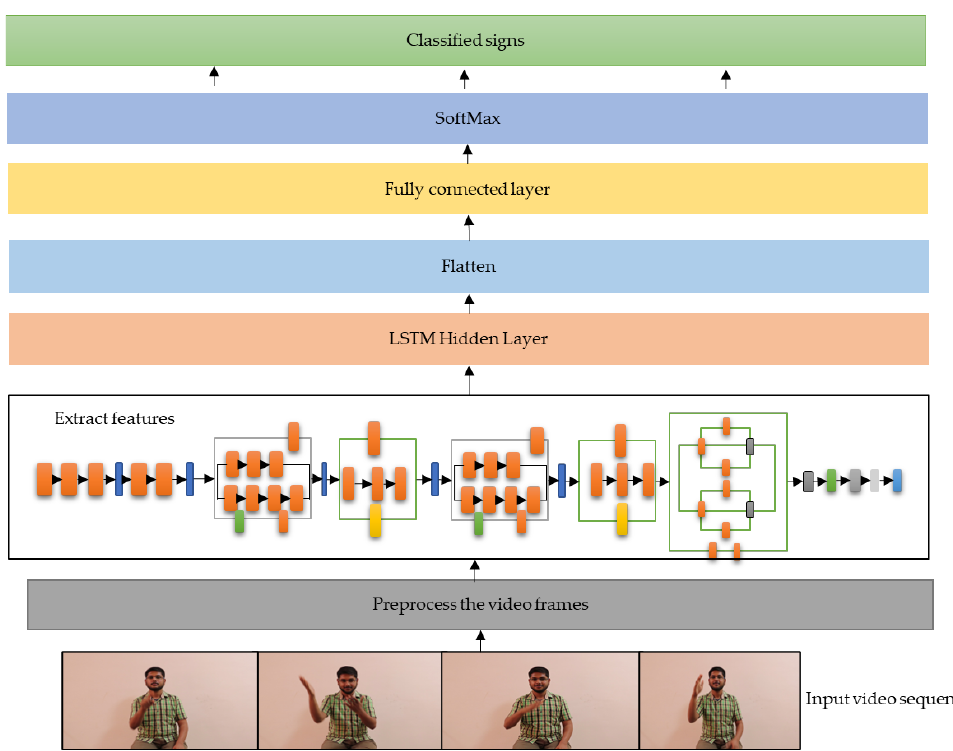
Figure 8. Various steps of the proposed Lightweight Sign language